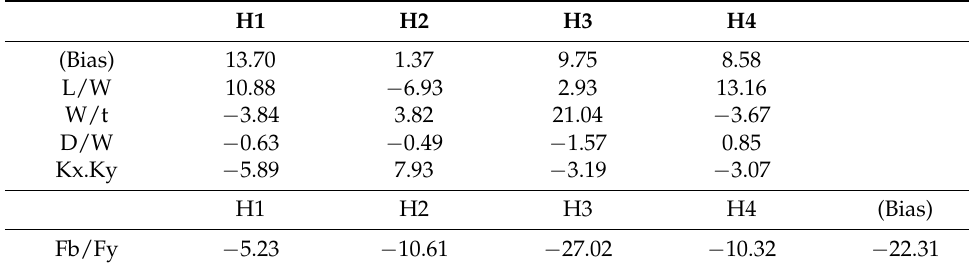
Figure 4. Layout for the developed ANN and its connection weights. Table 3. Weight matrix for the developed ANN